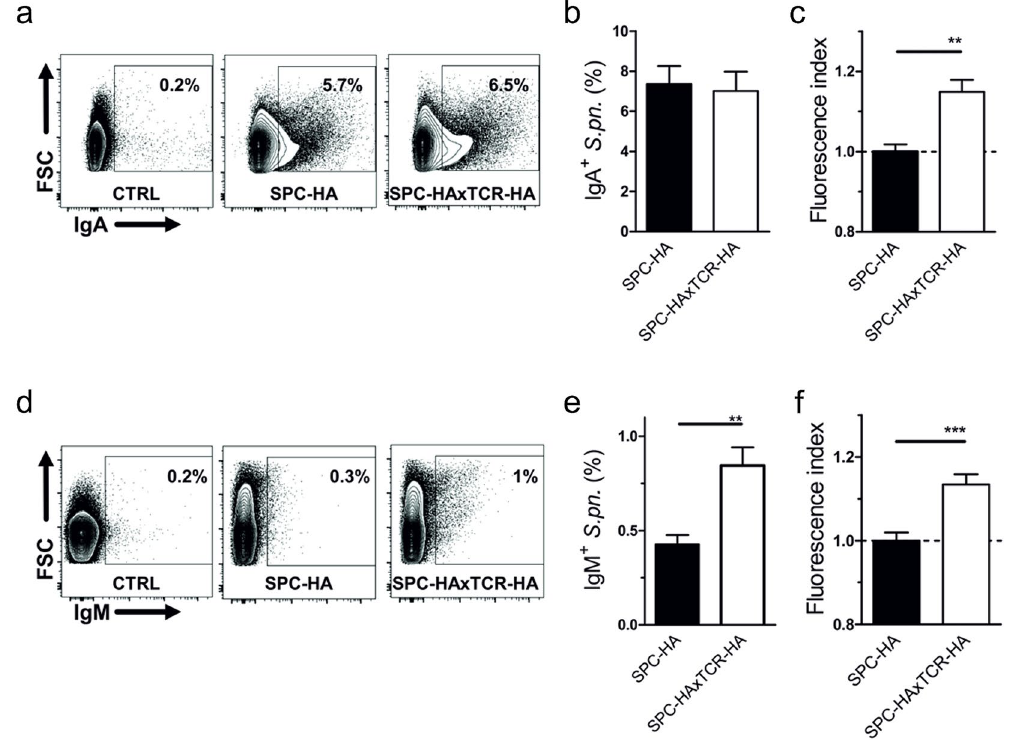
Figure 4. Increased pneumococcal binding capacities by lung mucosal fluid in inflamed lungs. Pneumococci were co-incubated with bronchoalveolar lavage fluid (BALF) supernatants from SPC-HA and SPC- HAxTCR-HA mice. Bacteria were stained with anti-mouse IgA or anti-IgM antibodies and analyzed by flow cytometry (FACS). ( a ) Representative FACS plots of IgA + pneumococci incubated with BALF from SPC-HA or SPC-HAxTCR-mice; control samples (CTRL) were stained with anti-IgA without prior incubation with BALF. ( b ) Percentages of IgA + pneumococci and relative fluorescence intensities ( c ) of IgA + pneumococci. ( d ) Representative FACS plots of IgM + pneumococci incubated with BALF from SPC-HA or SPC-HAxTCR- mice; control samples (CTRL) were stained with anti-IgM without prior incubation with BALF. ( e ) Percentages of IgM + pneumococci and relative fluorescence intensities ( f ) of IgM + pneumococci. Relative fluorescence intensities are calculated by the ratio of the MFI of each individual sample over the mean MFI of the SPC-HA control group. Data are pooled from 2 independent experiments with similar results. * p < 0.05 ** p < 0.01, *** p <